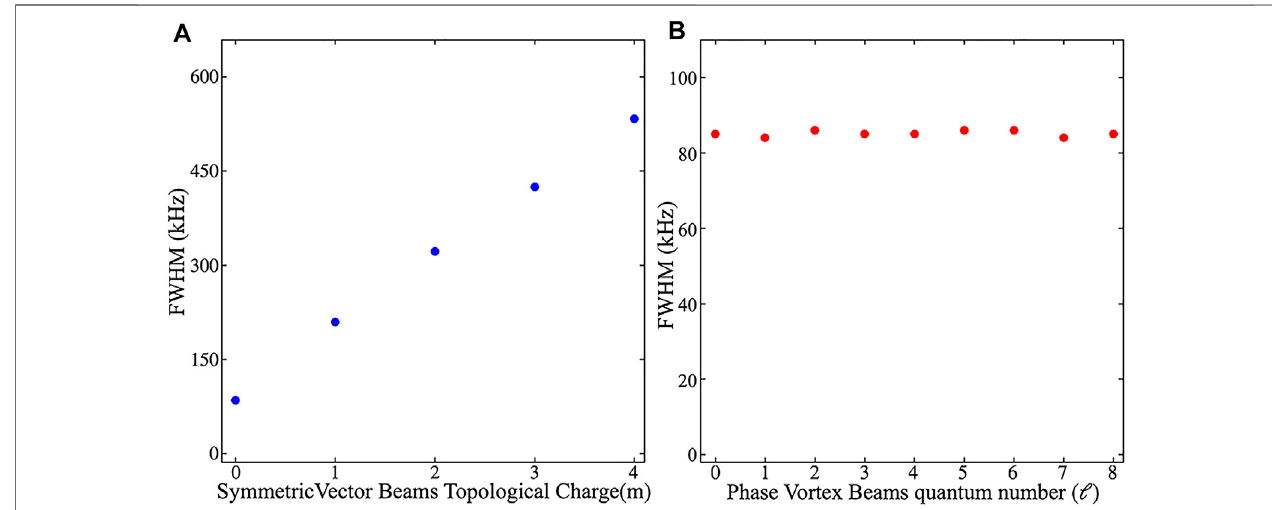
FIGURE5| Linewidths depend onthetopologicalcharge ofthesymmetricvectorbeam and thephase vortex beam. (A) FWHMsdepend on thesymmetricvector beam topological charge m; (B) FWHMs depend on the phase vortex beam topological charge ℓ .